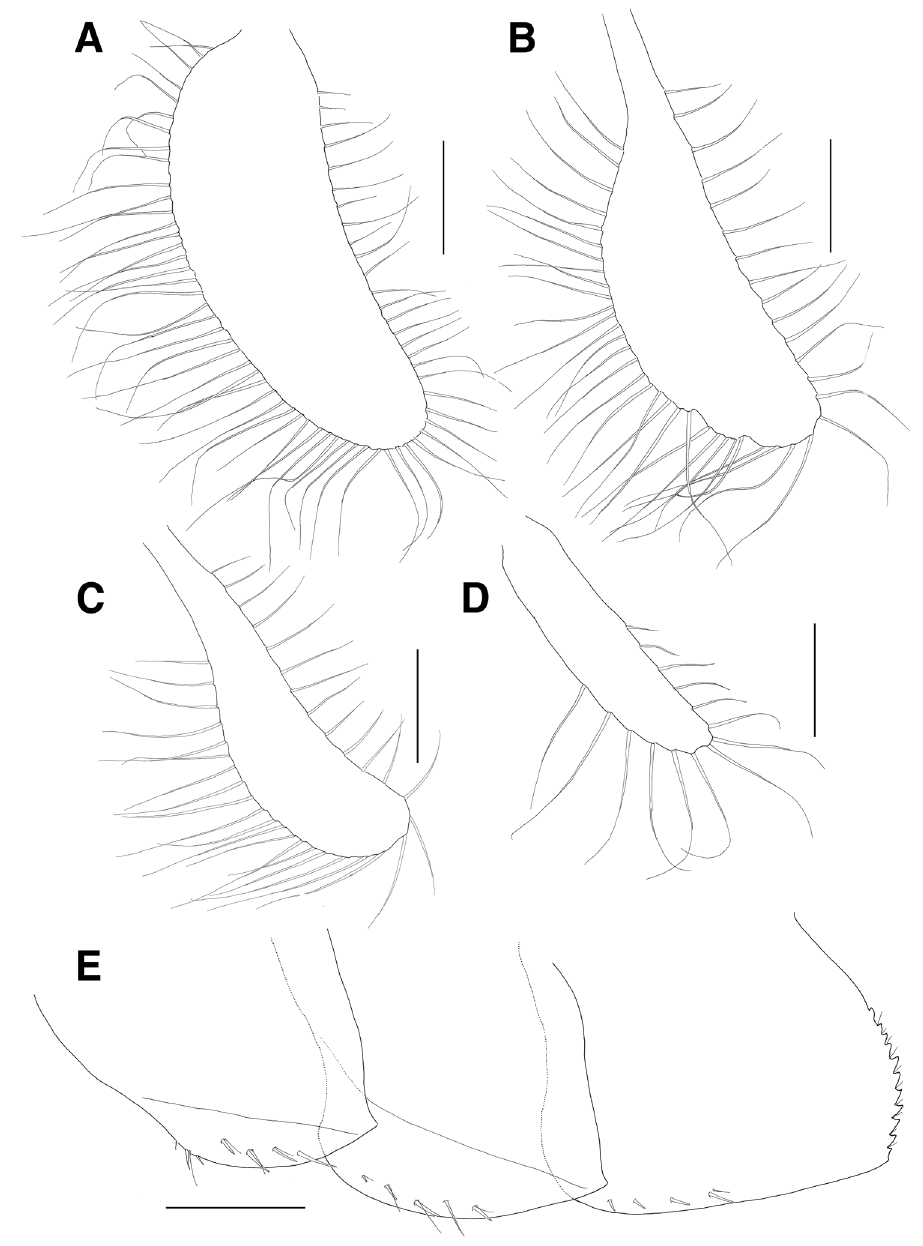
Figure 6. Eusiroides pilopalpus sp. n., holotype. A–D Oostegites of gnathopod 2–pereopod 5 E Pleonal epimera. Scale bars 0.5